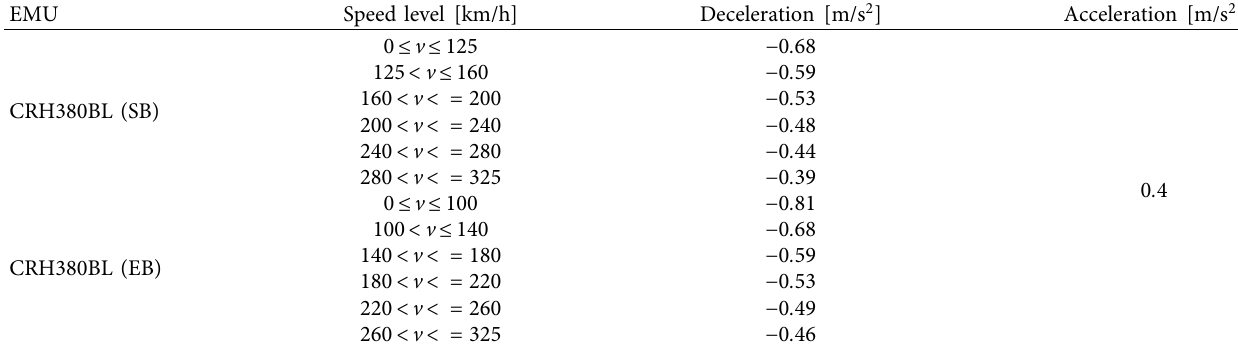
Table 4: ATP parameters of CRH380BL.